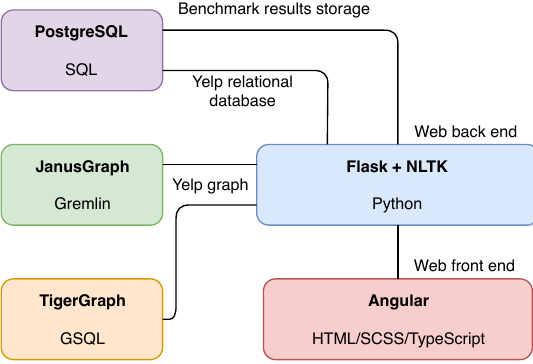
Figure 1. The architecture of